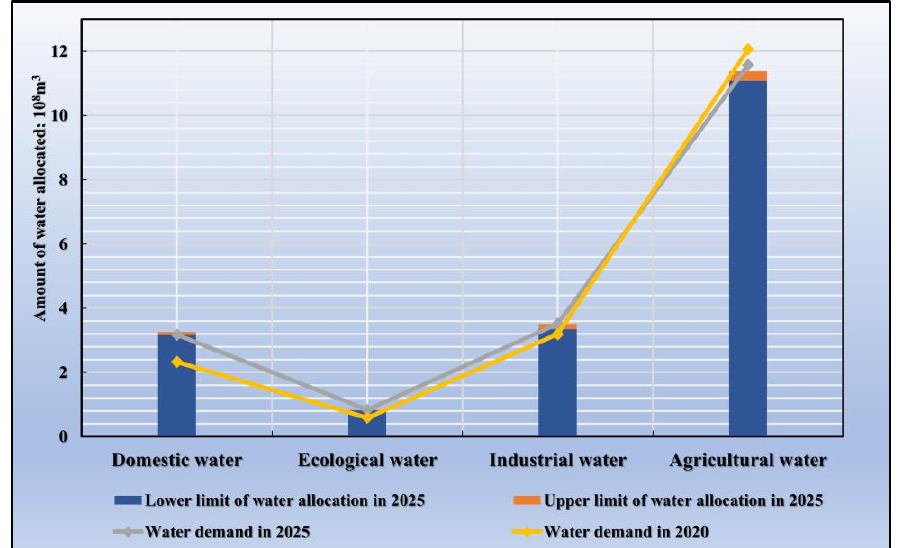
Figure 4. Water demand and water resource allocation in Binzhou in 2025.